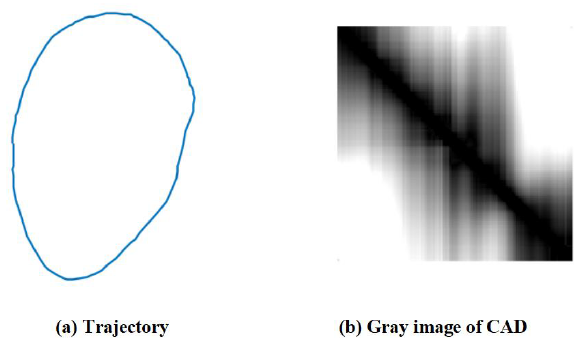
Figure 2. An example of trajectory and its gray image of